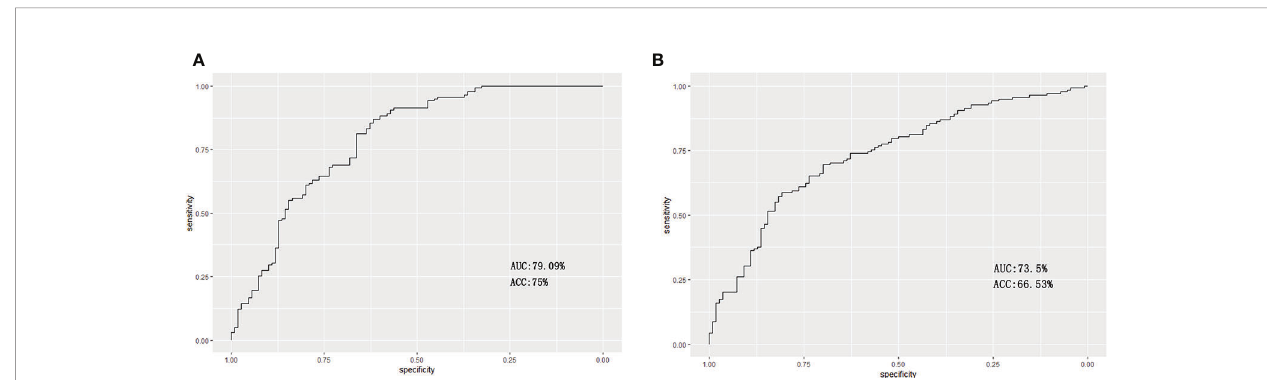
FIGURE 2 | Receiver operating characteristic curves for the prediction of invasiveness of ACPs in the training and validation sets. (A) For the training set, the area under the curve (AUC) was 79.09% with a sensitivity, speci fi city and accuracy of 81.97, 66.74, and 75%, respectively. (B) For the validation set, the AUC was 73.5% with a sensitivity, speci fi city and accuracy of 69.53, 72.44, and 66.53%,